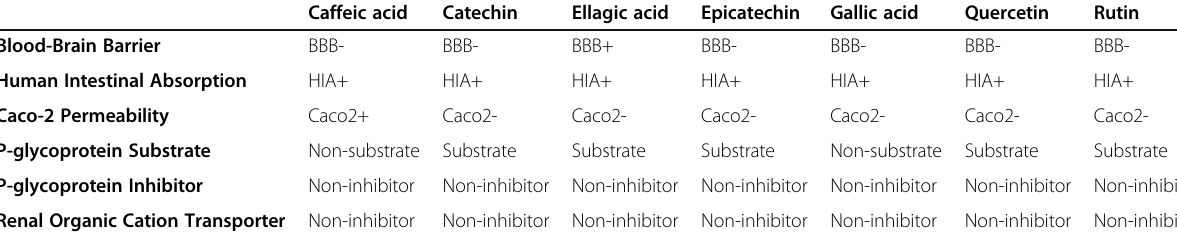
Table 2 Predicted Absorption of seven